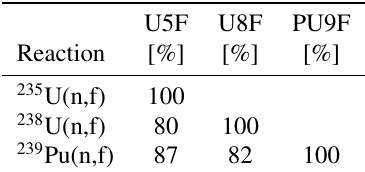
Table 8: Experimental correlations for Schröder et al. [16].